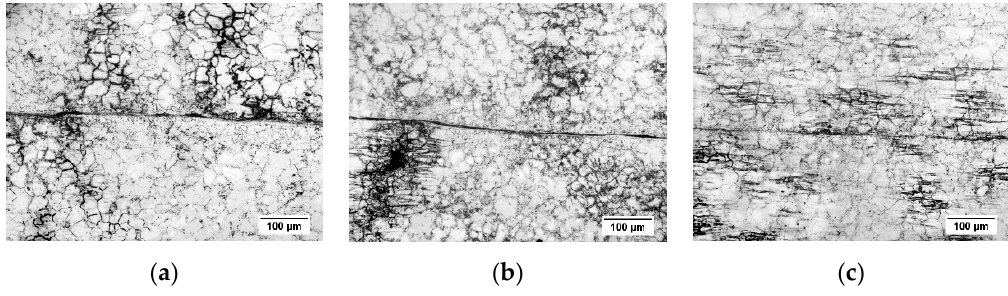
Figure 17. Microscopic morphology at different pressure amounts: ( a ) L = 100%; ( b ) L = 125%; ( c ) L = 150%.